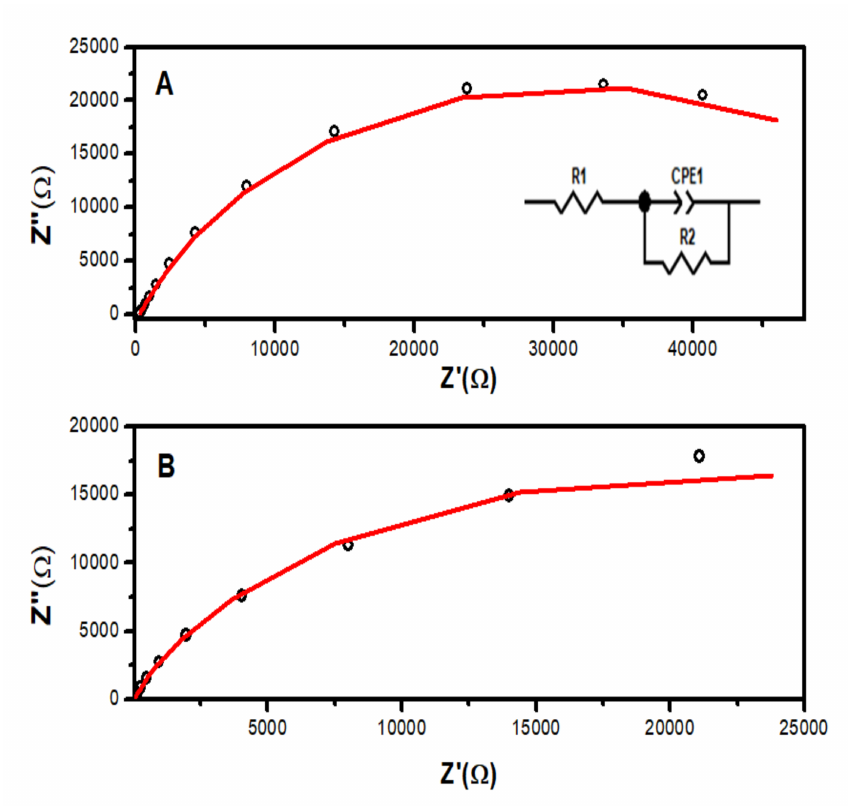
Figure 12. EIS data of PACHA coated gold electrodes at 0.1 V in ( A ) 0.06 M NaOH and ( B ) 1.8 M NaOH in the presence of 5 M CH 3 OH. The dotted data are the experimental results and the solid line is fitted data by an equivalent circuit (inset to Figure